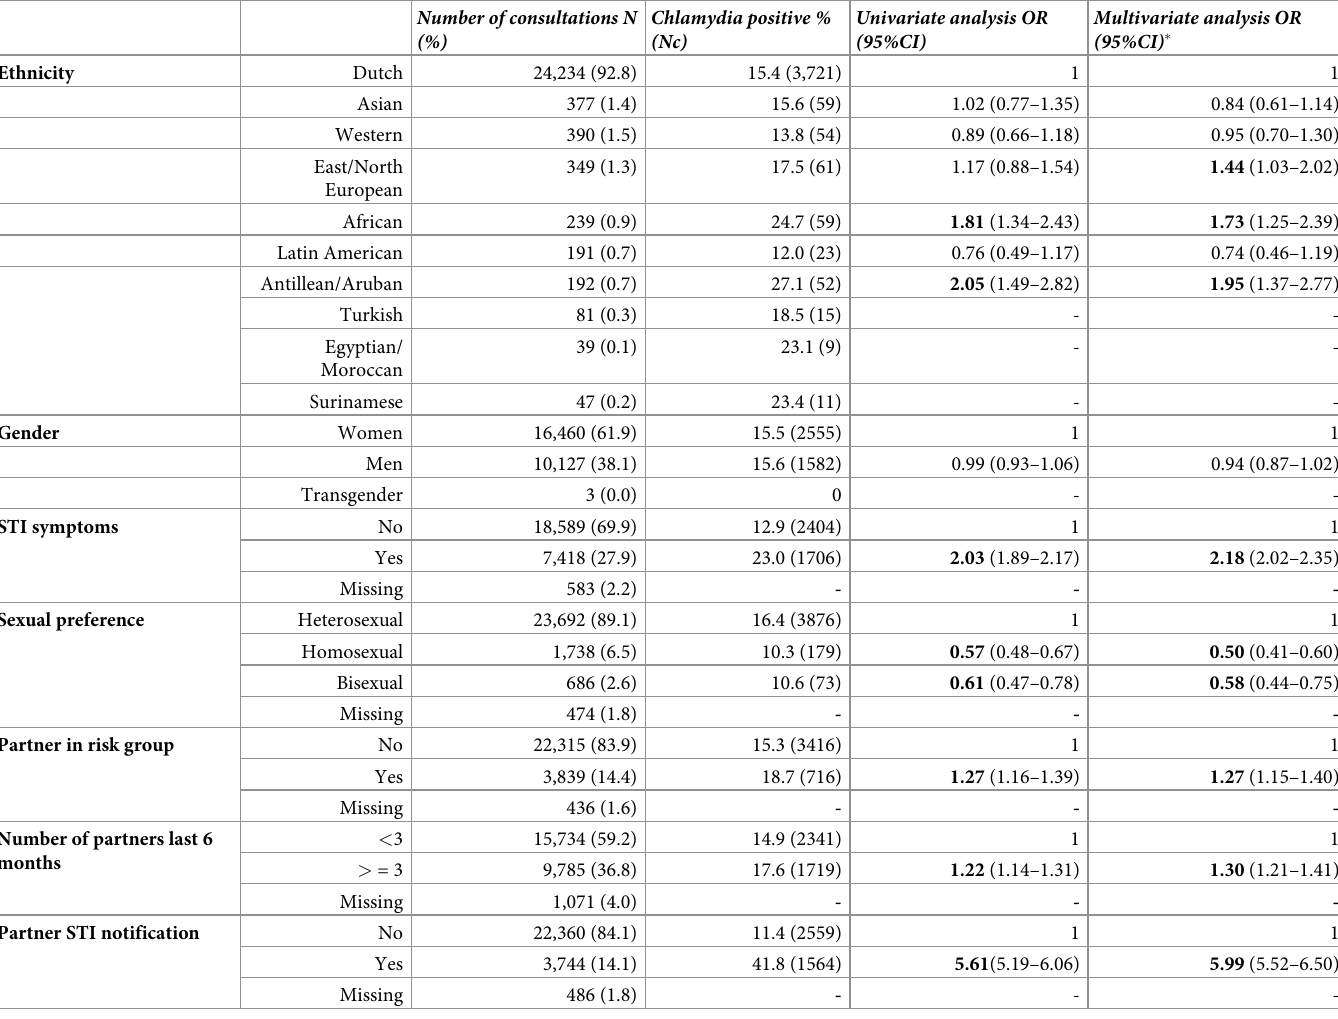
Table 2. Chlamydia positivity and determinants of chlamydia positivity in 26,590 consultations at STI clinics in the eastern part of the Netherlands,